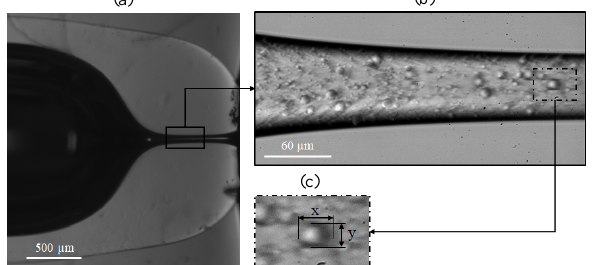
Figure 1. Setup for observing the particle deformation: (A) glass nozzle on the reference surface, (B) CMOS camera, (C) lenses, (D) light source, and (E) translation stage.